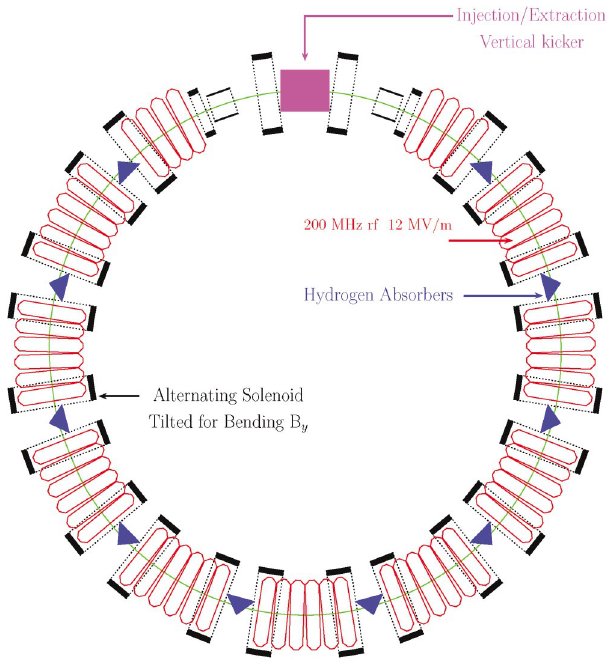
FIG. 16. (Color) Layout of RFOFO ring with injection/extrac- tion cells.